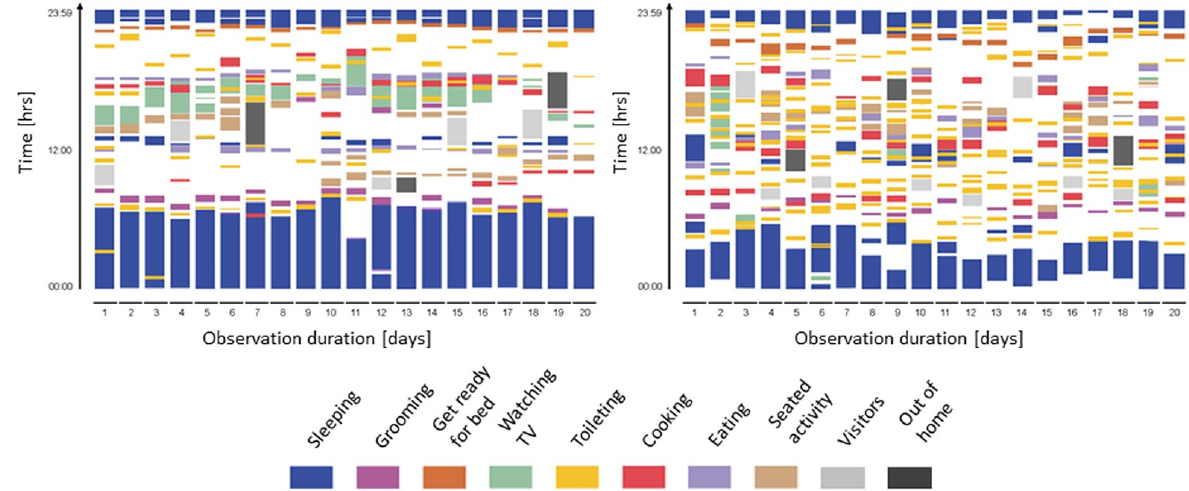
Figure 1. Floor plan of an apartment showing the placement of sensor boxes (red circles). The figure is adapted from Urwyler et al. [30] (CC BY 4.0).